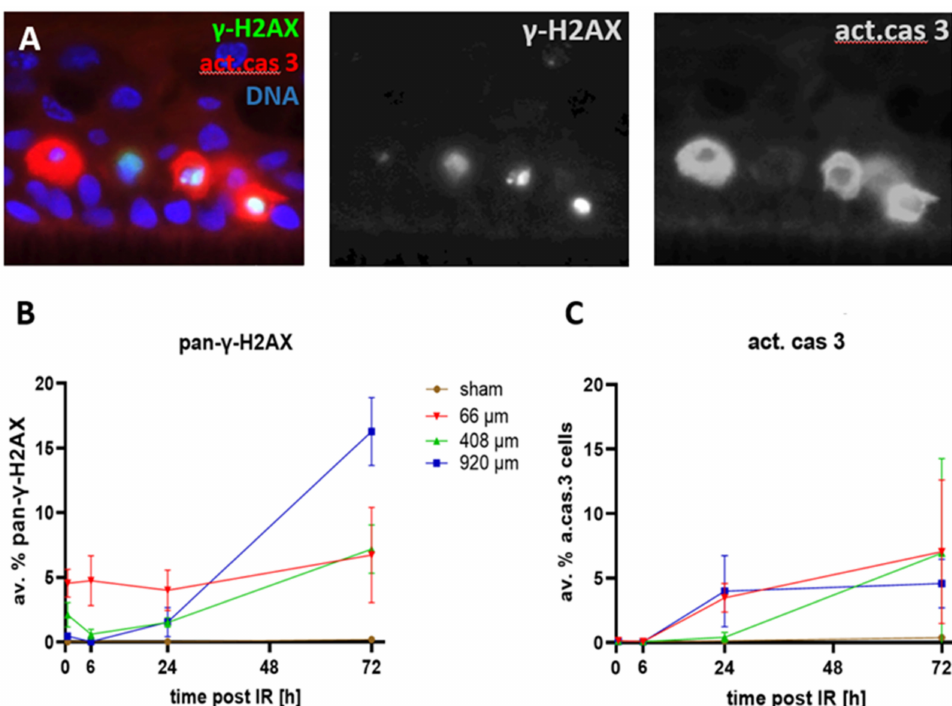
Figure 8. ( A ) Detail of an epidermis model showing active caspase-3 positive cells (red) contain pan- γ -H2AX-positive nuclei (green/yellowish) with nuclear fragments or pycnotic nuclei (left nucleus). Nuclear DNA: blue. Grayscale images of green and red channels to the right. The basal cell layer lies parallel to the lower edge of the image. ( B ) Frequency of pan- γ -H2AX cells over the time course. Sham-irradiated epidermides rarely displayed pan- γ -H2AX nuclei at all time points, ranging from an average of 0.07 to 0.4%. Wide-field (920 µ m) pMBRT induced a significant increase ( p < 0.05) of pan- γ -H2AX cells after 24 and 72 h. 408 µ m pMBRT induced elevated levels of pan- γ -H2AX-cells relative to sham 0.5–72 h post-IR. pMBRT of 66 µ m induced a significant increase of pan- γ -H2AX cells at all time points. ( C ) The average frequency of active caspase 3-positive cells in sham-irradiated tissue models was below 0.22% over the entire time course. pMBRT of 920 µ m and 66 µ m induced a significant increase ( p < 0.05) over sham 24 and 72 h post-irradiation, while for 408 µ m pMBRT, this was seen only at 72 h. Each data point represents the average ± SD of n = 9 sections of 3 independent epidermis models for each condition, except for 24 h sham ( n = 6) and irradiated models at 72 h ( n = 6). For data and p -values, see Supplementary Tables S2 and